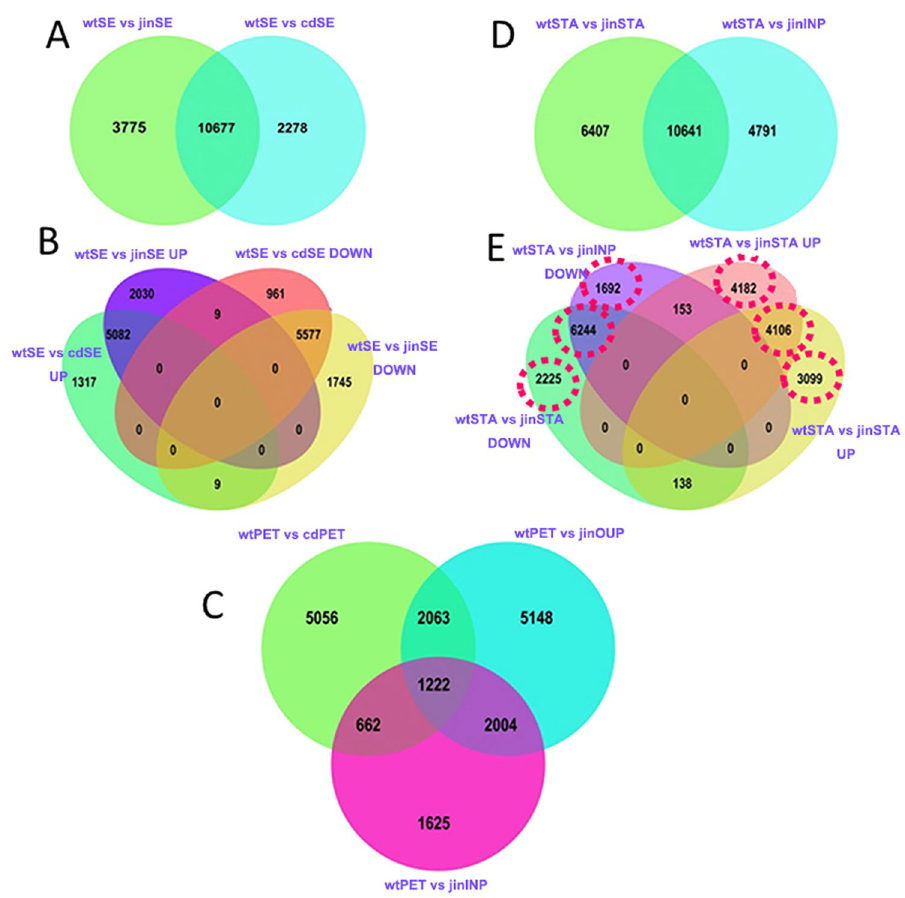
Figure 2. The venn diagram plots of distribution of DEGs. ( A ) Common and special DEGs between sepals of wild and double flower cultivars. ( B ) 4-way venn diagram of up and down regulated DEGs between sepals of wild and double flower cultivars. ( C ) Common and special DEGs between petals of wild and double flower cultivars. ( D ) Common and special DEGs between stamen like organs of wild and double flower cultivars. ( E ) 4-way venn diagram of up and down regulated DEGs between stamen and inner organs of wild and double flower cultivars. The sample labels were described in Fig. 1, and UP indicated up-regulated genes, DOWN indicated down-regulated genes in each